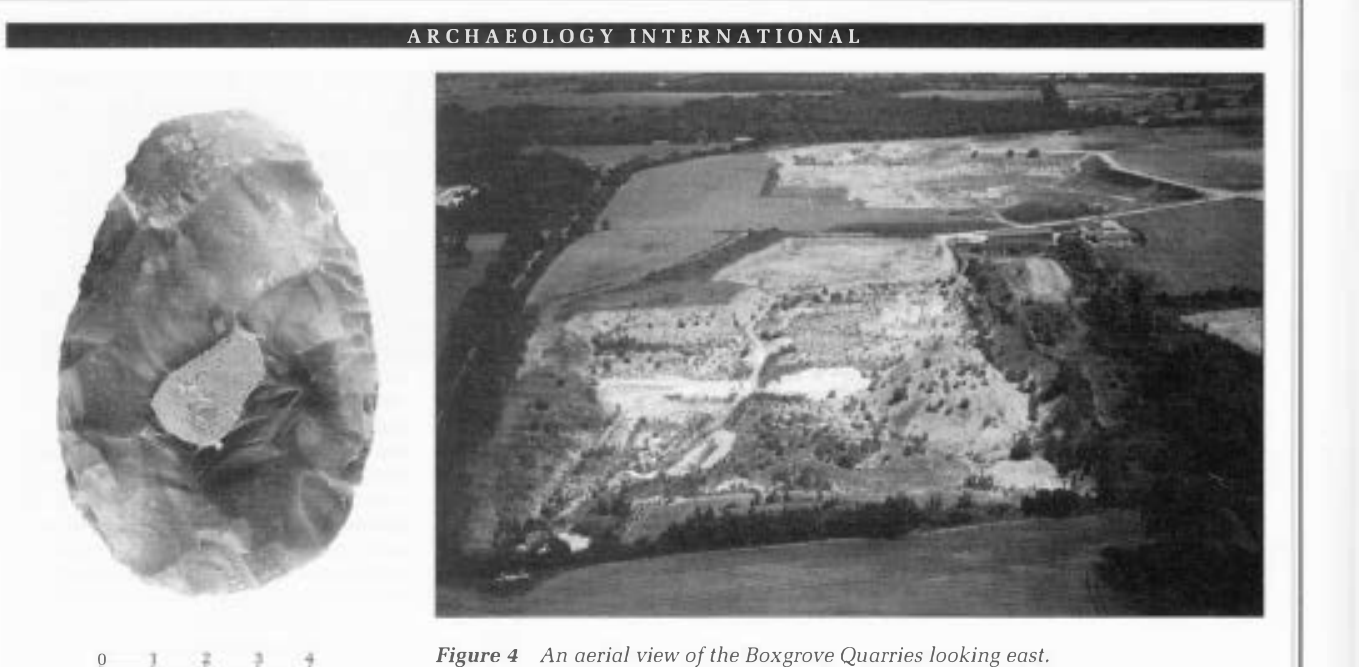
Figure 4 An aerial view of the Boxgrove Quarries looking east.